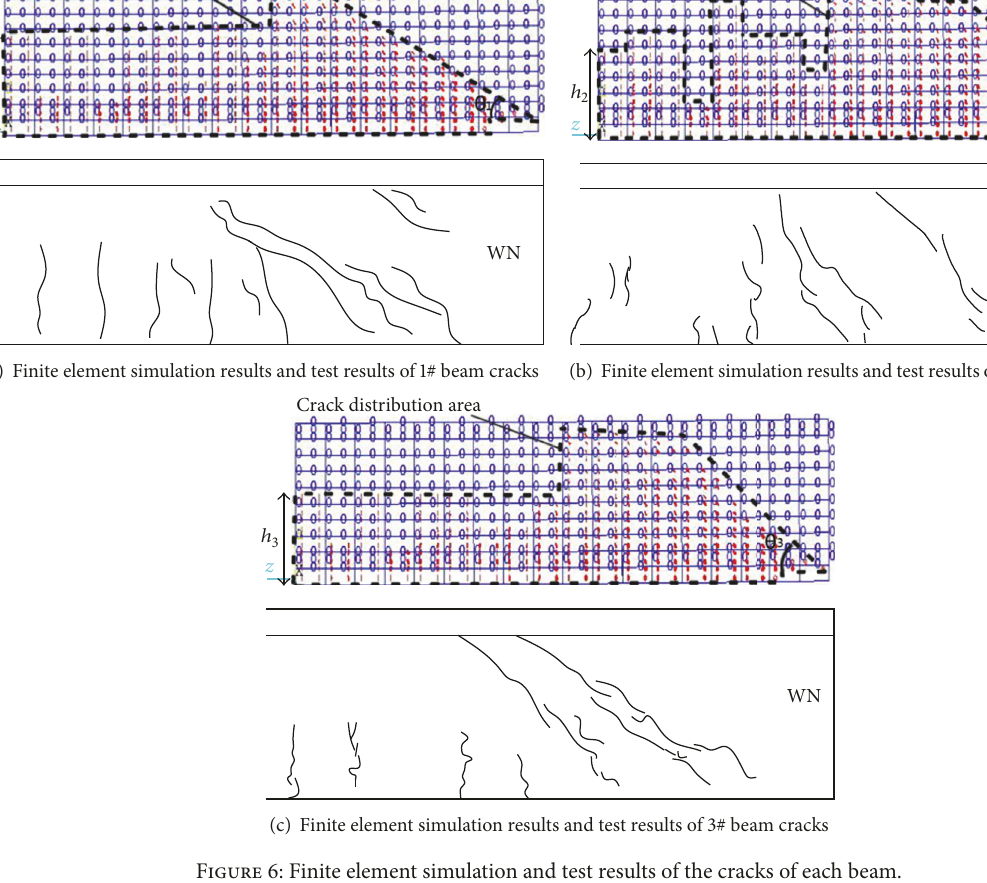
Figure 6: Finite element simulation and test results of the cracks of each